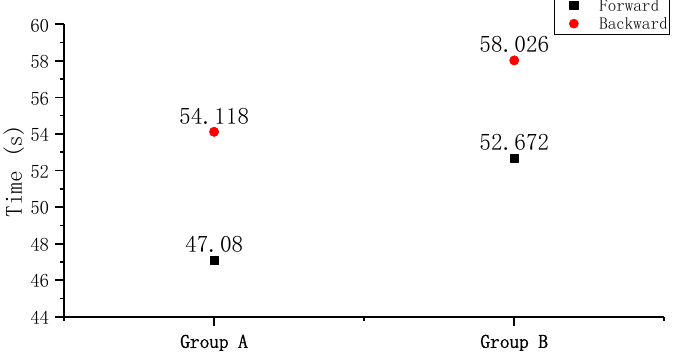
Figure 5. The averaged elapsed time of two groups of PZT pumps in the forward and backward